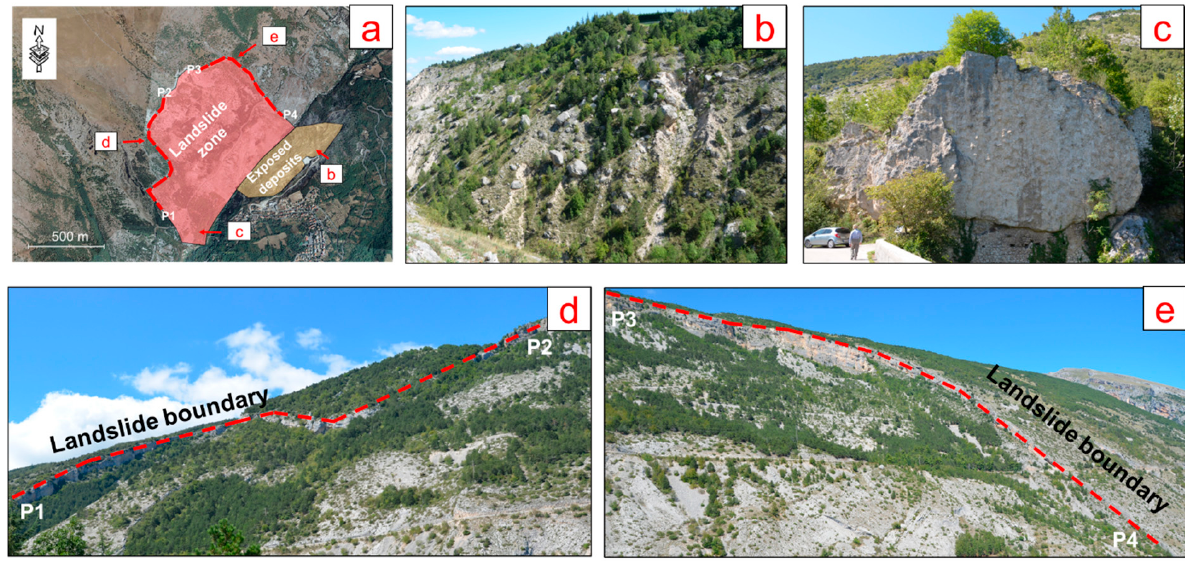
Figure 3. Landslide scar and deposits, ( a ) the extent of the ancient landslide and the deposit, ( b ) landslide deposits characterized by scree and talus, ( c ) an isolated rock block located by the river, ( d ) the SW headscarp of the landslide, ( e ) the NE headscarp of the landslide.